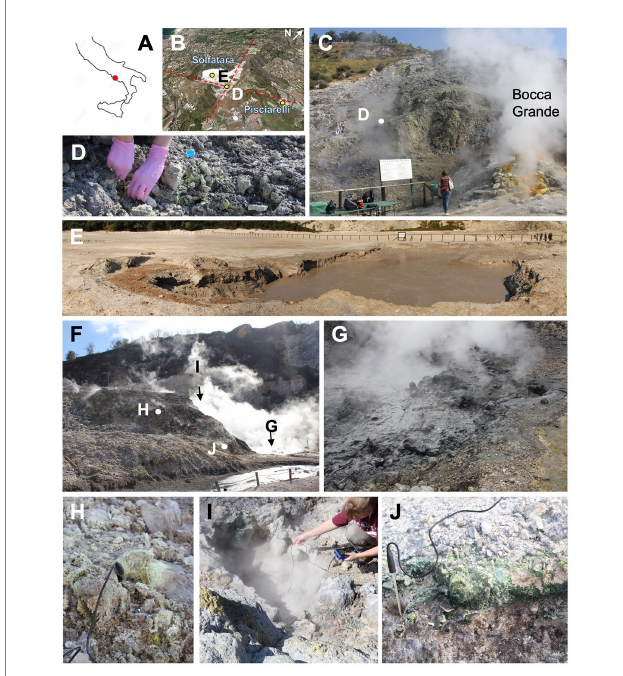
FIGURE 1 Sampling points at Solfatara-Pisciarelli hydrothermal systems. (A) Location map of Solfatara-Pisciarelli hydrothermal systems on contoured map of Italy (red dot). (B) Oblique view of Solfatara and Pisciarelli systems; red dashed lines represent faults; yellow dots are sampling points (E and D stand for Solfatara mud pool and fumaroles, respectively). (C) Sampling point of Solfatara fumarolic deposits (SF) next to the main fumarole Bocca Grande. (D) Close-up view of deposits to show heterogenicity of the material in regard to grain size and mineralogy (note different colors of deposits). (E) Solfatara mud pool (SMP) with bubbling water and warm muddy substrate near the pool. (F) Overview of the Pisciarelli location with marked sampling points. (G) Pisciarelli large pool (PLP) with bubbling hot mud (temp. 84.1 ° C). (H) Pisciarelli fumarolic deposits (PF) with sulfur crystals precipitate. (I) Pisciarelli small pool (PSP) sampling point. (J) Pisciarelli epilithic microbial layer (PLP-E) observed and sampled on the wall near the outflow channel of the large